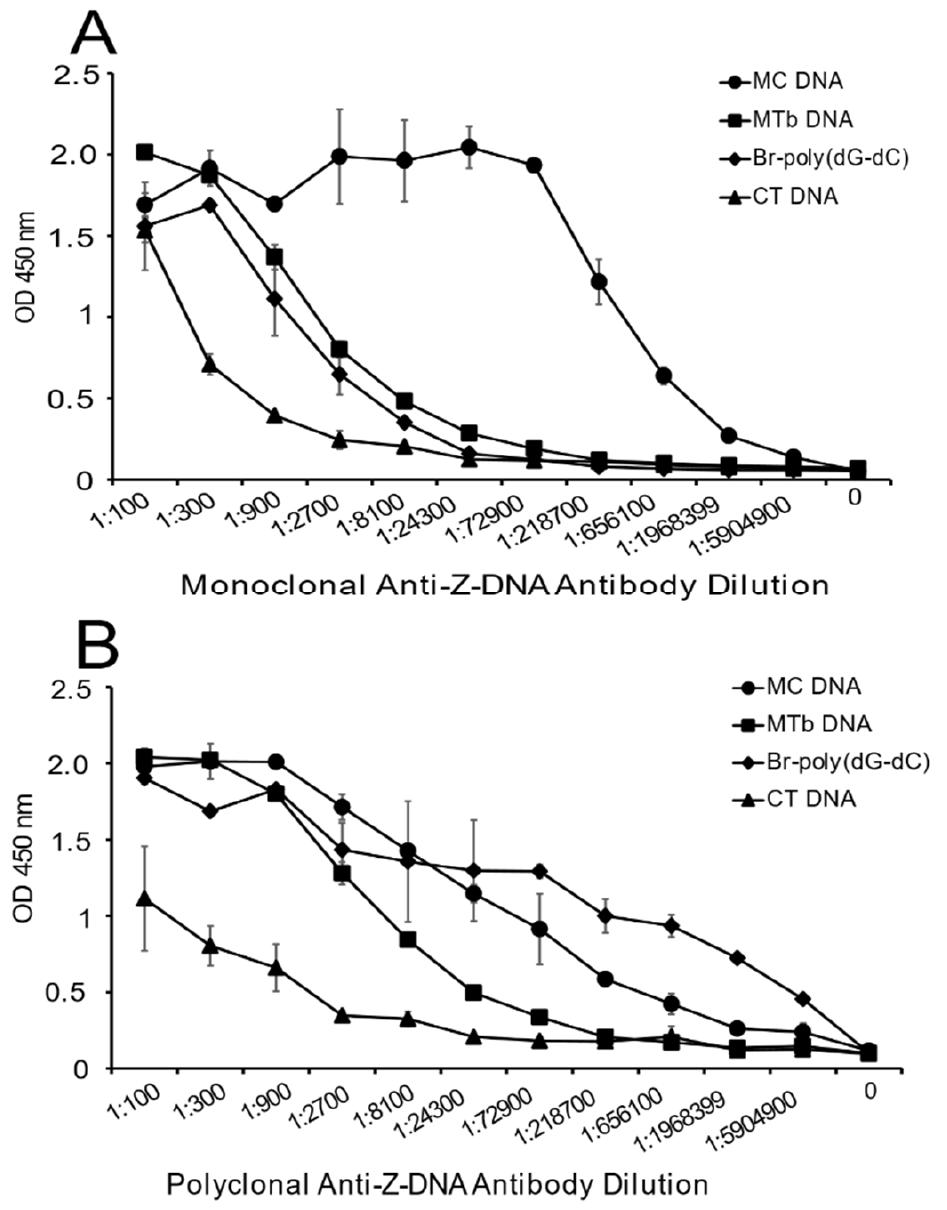
Figure 4. The binding of monoclonal ( A ) and polyclonal ( B ) anti-Z-DNA antibodies to DNA from Mycobacterium tuberculosis. The binding of various dilutions of the anti-Z-DNA antibodies to MTb DNA was assessed by ELISA. All DNA antigens were coated at a concentration of 2 µ g/mL. Results are reported as OD 450 nm values. All treatments were performed in duplicate. Means and standard deviations are shown.